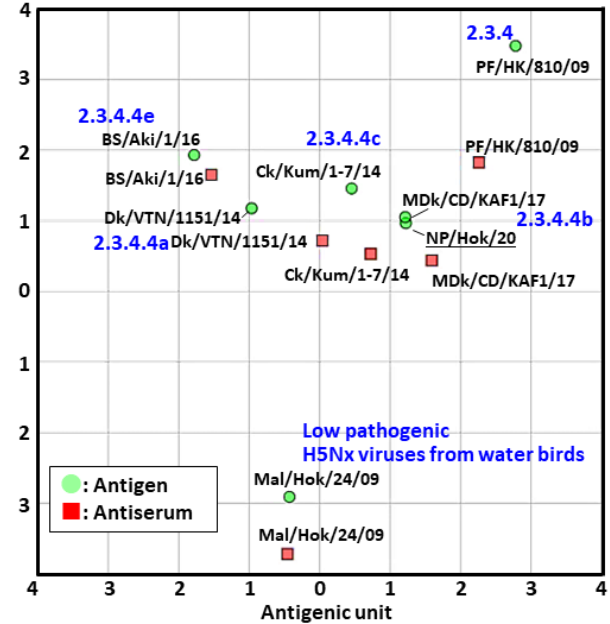
Figure 3. An antigenic map based on the cross-hemagglutination inhibition (HI) tests on H5 clade 2.3.4.4 viruses and the sera of different genetic groups. The antigenic relationship among H5 clade 2.3.4.4 viruses, including NP/Hok/20, was visualized using antigenic cartography based on the results of the cross-HI tests, as indicated in Table S1. In an antigenic map, both vertical and horizontal axes represent the antigenic distance, and the spacing between grid lines represents a distance of 1 antigenic-unit distance, which corresponds to a 2-fold dilution in the HI assay.